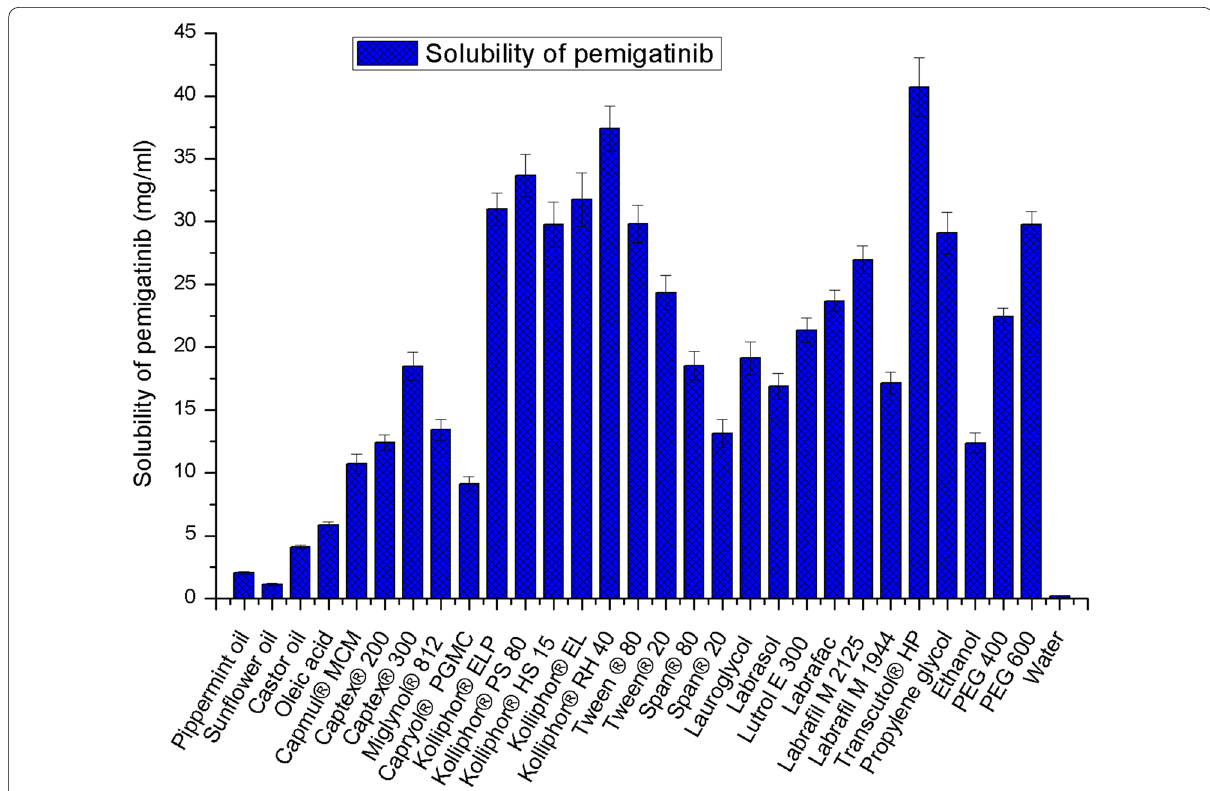
Fig. 1 Solubility of Pemigatinib in different